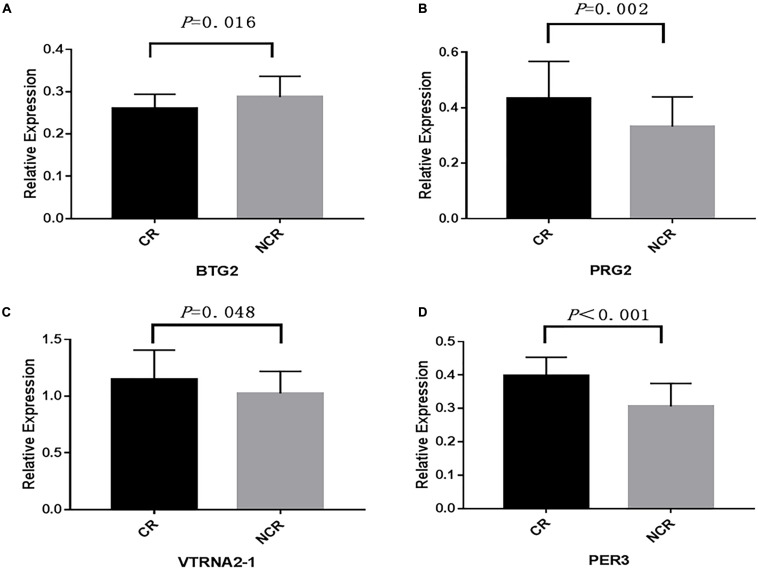
A comparison of the mRNA expression of four genes. (BTG2, PRG2, VTRNA2-1, PER3) between CR and non-CR. (The mean relative expression of mRNA: (A) BTG2, CR vs. NCR: 0.267 ± 0.031 vs. 0.293 ± 0.044, P = 0.016. (B) PRG2, CR vs. NCR: 0.423 ± 0.163 vs. 0.336 ± 0.096, P = 0.002. (C) VTRNA2-1, CR vs. NCR: 1.167 ± 0.285 vs. 1.007 ± 0.213, P = 0.048. (D) PER3, CR vs. NCR: 0.397 ± 0.056 vs. 0.308 ± 0.072, P < 0.001).